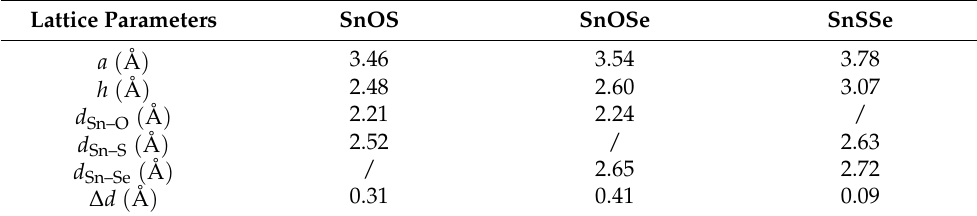
Figure 1. ( a ) Top- and ( b ) side-views of the crystal structure of the Janus monolayers SnXY, where the lattice constant ( a ) and layer thickness ( h ) are marked. Table 1. The lattice constant ( a ), the layer thickness ( h ), the bond lengths ( d Sn–X , d Sn–Y ) and their difference ( ∆ d ) of three typical Janus